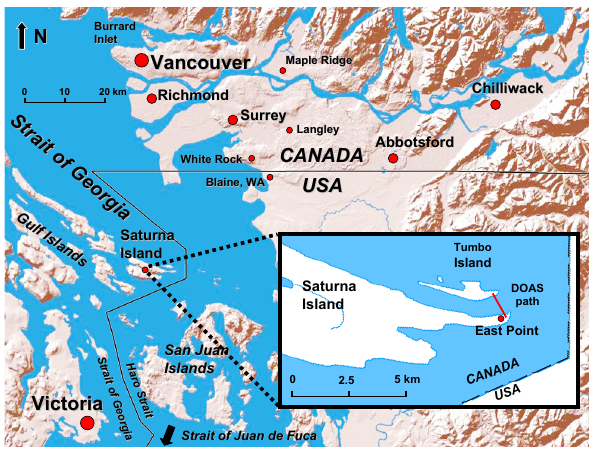
Fig. 1. Study location.